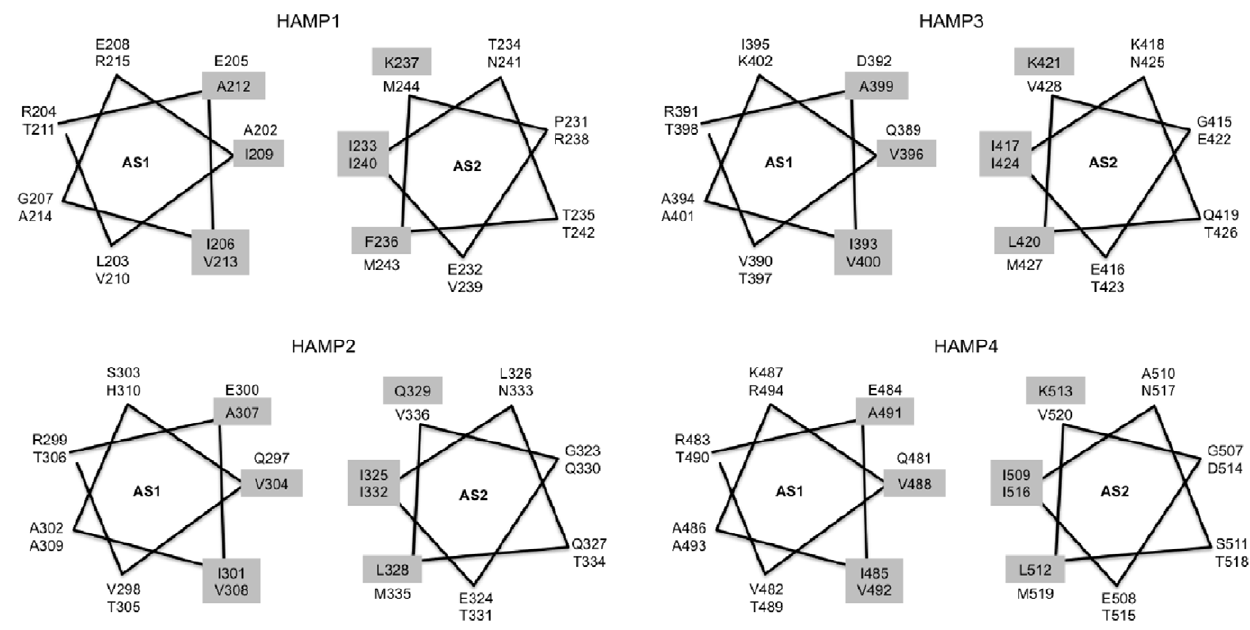
Figure 4. 2D-schematic representation of the helical arrangement of connector proximal helices from HAMP domains 1–4. Two helical turns of seven amino acids each are listed. Both helices are facing each other such as in the model of Figure 1. The grey shading highlights interacting residues. AS1=amphipathic helix 1; AS2=amphipathic helix 2.